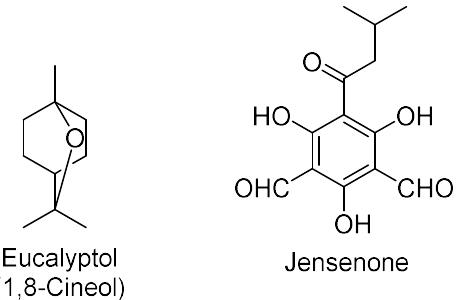
Figure 1. Structures of eucalyptol and jensenone, the active components of eucalyptus oil.